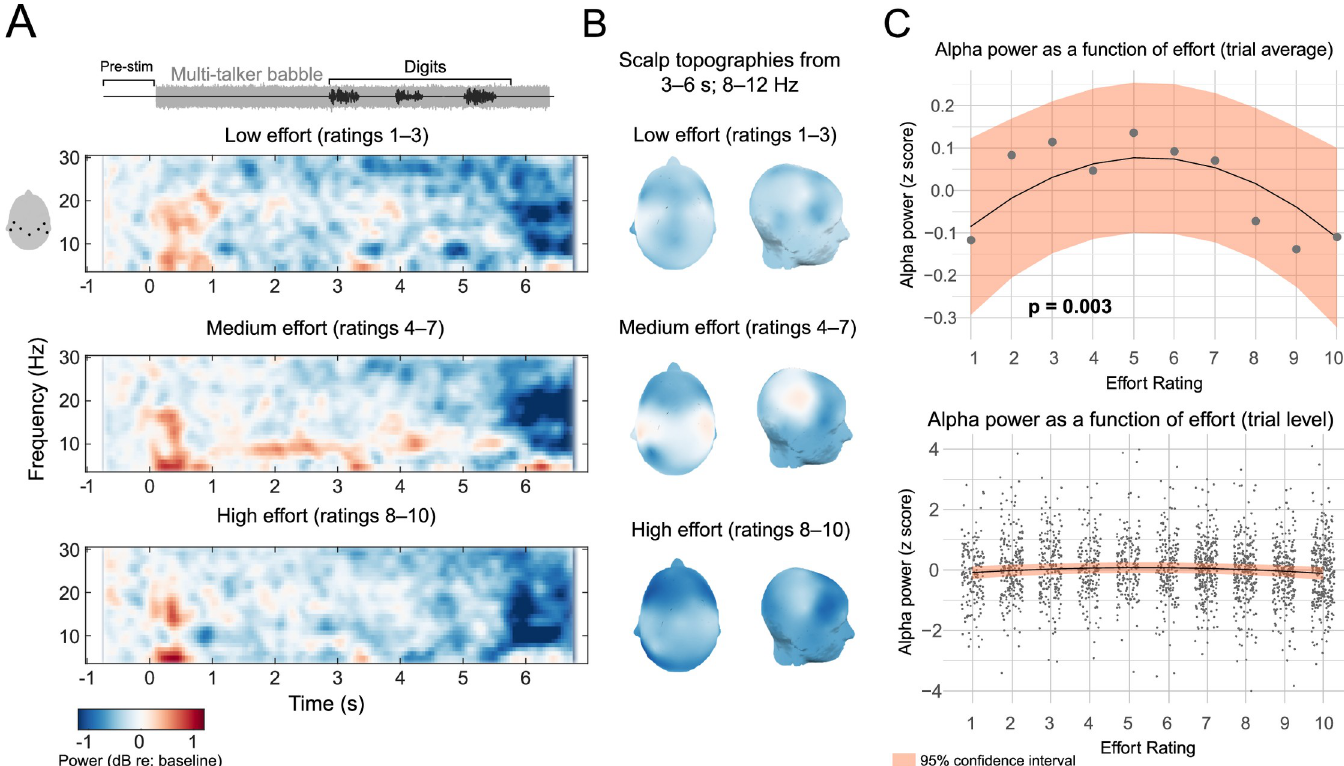
Fig 4. Parietal EEG alpha power as a function of listening effort in CI users. A) The three time-frequency plots depict wideband power (expressed as a dB change relative to baseline) averaged across low, medium, and high effort rating groupings in seven posterior channels (channel locations plotted adjacent to the top plot). These bins, though unbalanced between categories, were chosen for the sake of illustration. Red shading indicates higher power compared to baseline, and blue shading represents lower power. Above the time-frequency plots is a schematic describing the acoustic waveform across the trial structure, including the babble noise and digits. Note that effort groupings are for visualization, as single trials were the basis for inferential analysis. Further, these plots are an average of time frequency representations across participants, where trials were averaged before time frequency decomposition. Single-trial time frequency representations were submitted to mixed modeling. B) Topographic maps showing alpha power averaged over the 3- to 6- second time window. The left column is a top view of the scalp, and the right column is the right view of the scalp. C) The upper panel plots the inverted U function between listening effort ratings and alpha power (z-scored). The grey dots represent averaged alpha power at each effort rating level. The black line and orange shaded area are the regression lines from the single-trial analysis, bounded by 95% confidence intervals. The lower panel plots the same regression line and confidence intervals as in the upper panel, but the grey dots are z-scored alpha power for each trial. Note that individual trials are jittered around each effort level for